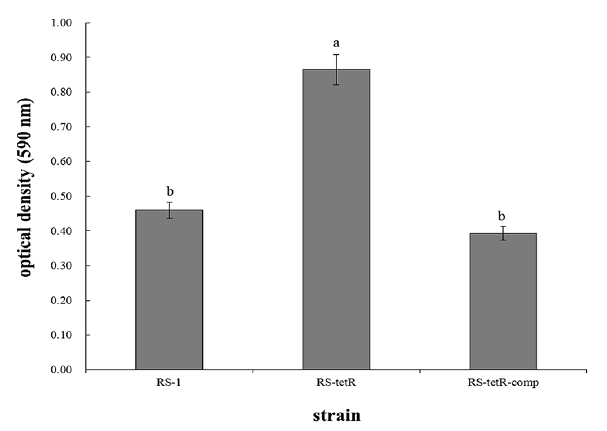
FIGURE 3 | Biofilm quantification and optical density measurements at 590 nm. Bacterial cells were placed in 96-well plate at 30 ◦ C without agitation. After 48 h, biofilm was formed and stained by 0.1% (w/v) crystal violet solution before releasing by 33% acetic acid. Means ± SEM are shown; n = 12. Different letters indicated significant differences ( P < 0.05) among